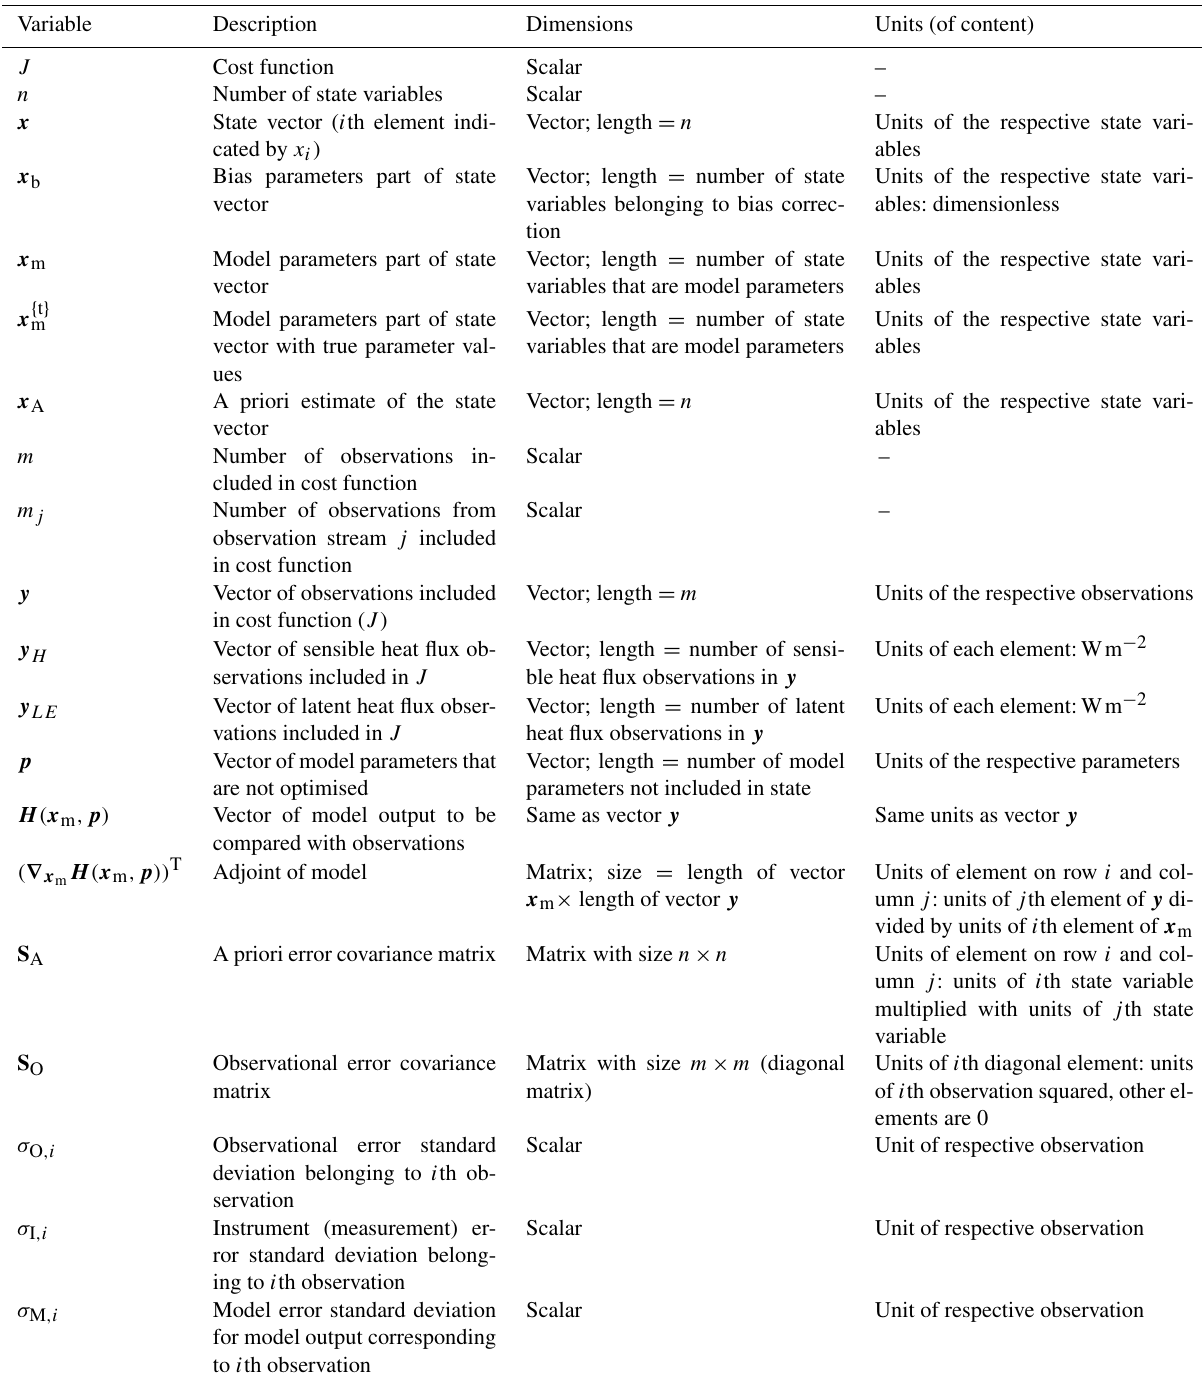
Table B1. Description, dimensions, and units (of content) of inverse-modelling variables used in Sect. 3.1 and 3.4 of this